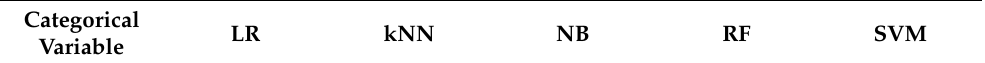
Table 3. Comparison of the cross-validation results of the two model types established using various machine learning